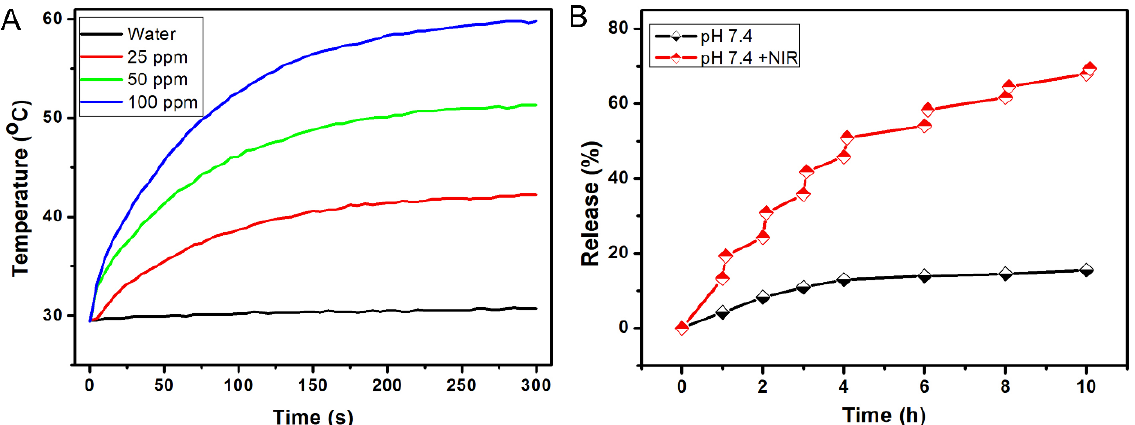
Figure 2. Photothermal and NIR-triggered drug-release properties of self-assembled CuCo 2 S 4 NCs/CL nanocomposites. ( A ) Temperature-rise curves of self-assembled CuCo 2 S 4 NCs/CL nanocomposites in aqueous solution at 0, 25, 50, and 100 ppm under the irradiation of the 808 nm NIR laser. ( B ) Drug-release curves of CL from self-assembled CuCo 2 S 4 NCs/CL nanocomposites in PBS (pH 7.4) with or without 808 nm NIR laser irradiation (0.56 W cm −2 ) at room temperature.